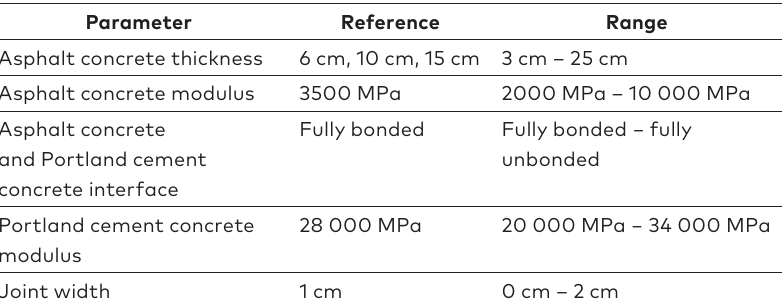
Table 2. Pavement parameters reference